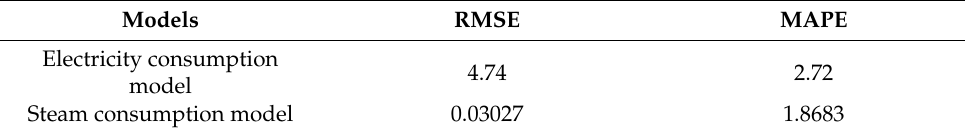
Table 8. The RMSE and MAPE of the rebuilt